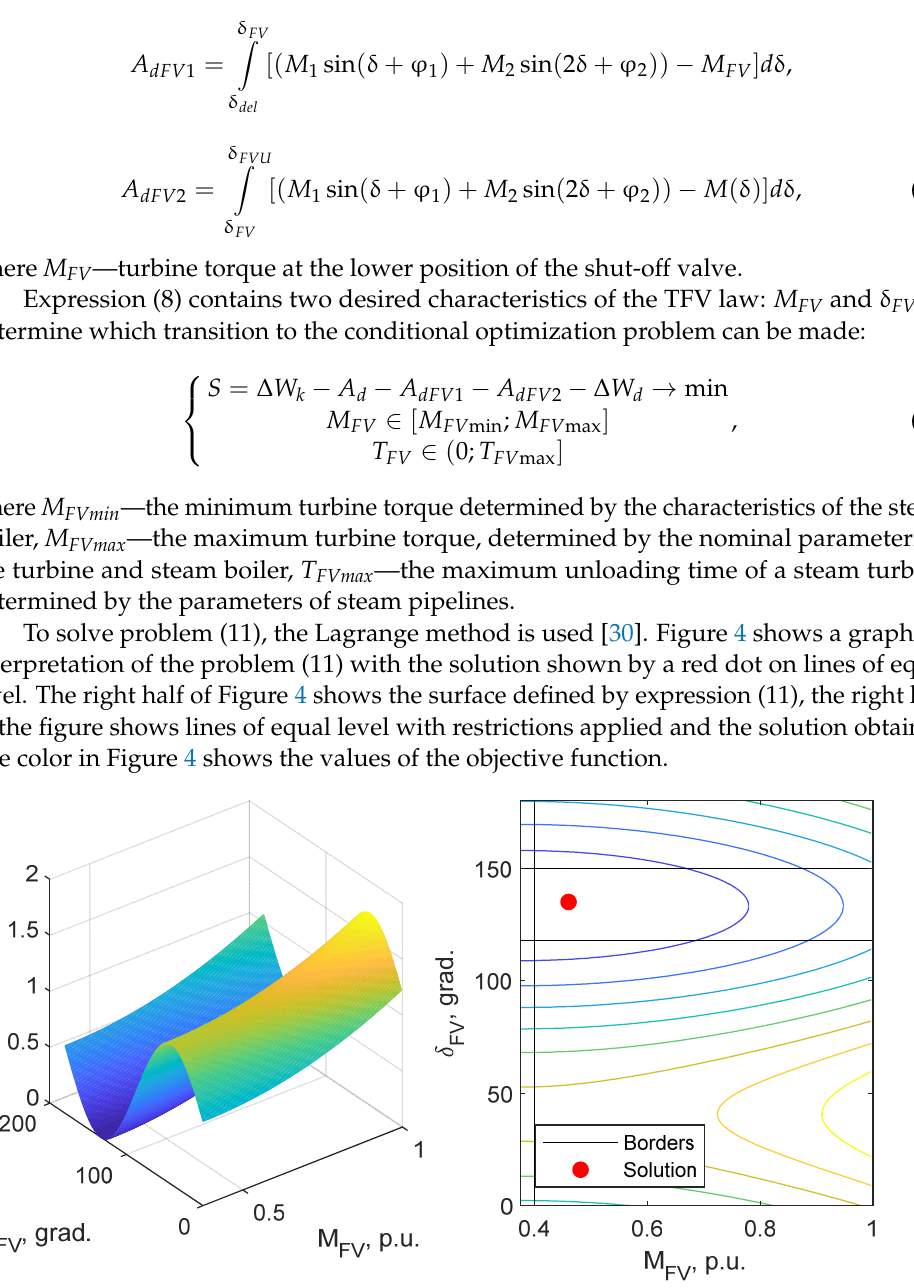
Figure 4. An example of determining the characteristics of the TFV law.